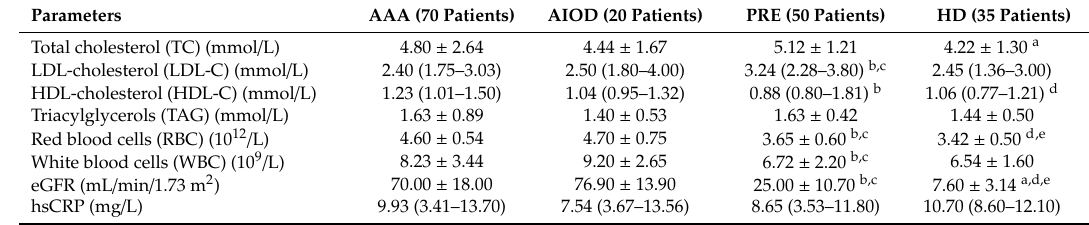
Table 2. Biochemical baseline characteristics of AAA, AIOD, PRE, and HD